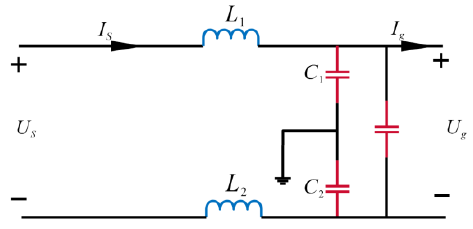
Figure 16. Topology for an LC hybrid filter.